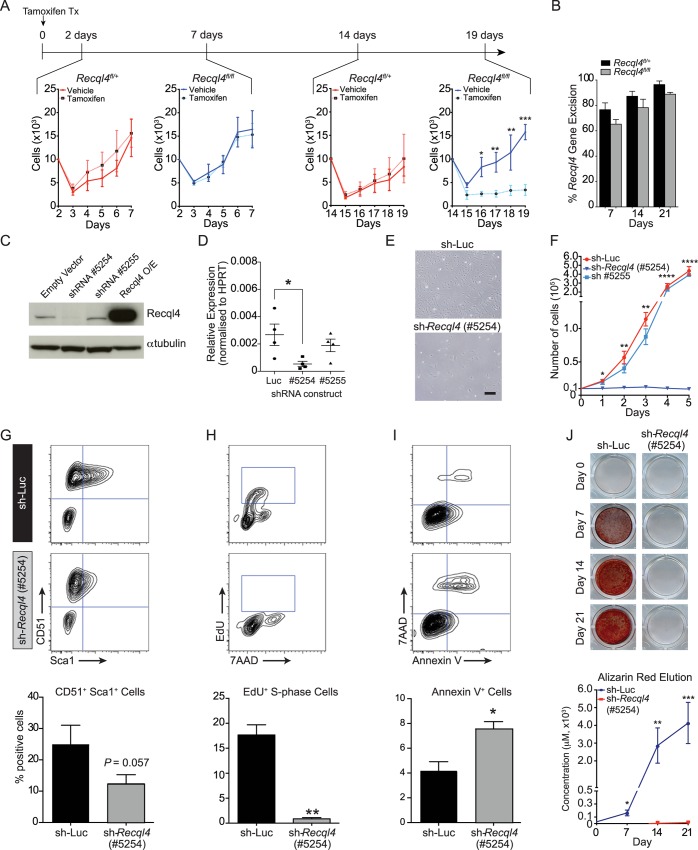
The depletion of Recql4 in vitro causes proliferation arrest.(A) Primary long bone osteoblastic cells were derived from Rosa26-CreERT2
Recql4 mice treated with tamoxifen and subjected to proliferation assays. n = 3 independent cultures per genotype. (B) The assessment of Recql4 genomic excision from tamoxifen-treated osteoblastic cells. n = 3 independent cultures per genotype. (C) Immuno-blot of Recql4 protein levels from Kusa4b10 cells, with α-tubulin as a loading control. (D) Quantitative real-time PCR (qPCR) analysis of Recql4 from Kusa4b10 cells. Relative gene expression levels were normalised to the expression of Hprt. n = 4 biological replicates. (E) Light microscopic images of control (shRNA-Luc) and sh-Recql4 (#5254) Kusa4b10 cells (200X magnification). (F) shRNA-Luc and sh-Recql4 (#5254) cells were seeded in 6-well plates and cell counts were performed at 24hr intervals. n = 4 independently infected cultures. (G-I) Control (shRNA-Luc) and sh-Recql4 (#5254) cells were seeded 24 hrs prior to flow cytometry analysis, and were stained with antibodies against CD51 and Sca1 (G), EdU and 7AAD (H), and Annexin V and 7AAD (I). Representative FACS plots shown on the top, percentages of stained cells summarised in bar graphs at bottom. n = 3–4 biological replicates. (J) shRNA-Luc and sh-Recql4 (#5254) cells were subjected to osteogenic differentiation and stained with Alizarin Red. Representative photos are shown at top, while the quantification of eluted Alizarin Red dye is shown at the bottom. n = 3 biological replicates; All graphical data presented as mean±SEM. *P<0.05, **P<0.01, ***P>0.0005, ****P>0.00001 compared with control, t-test or 2-way ANOVA.